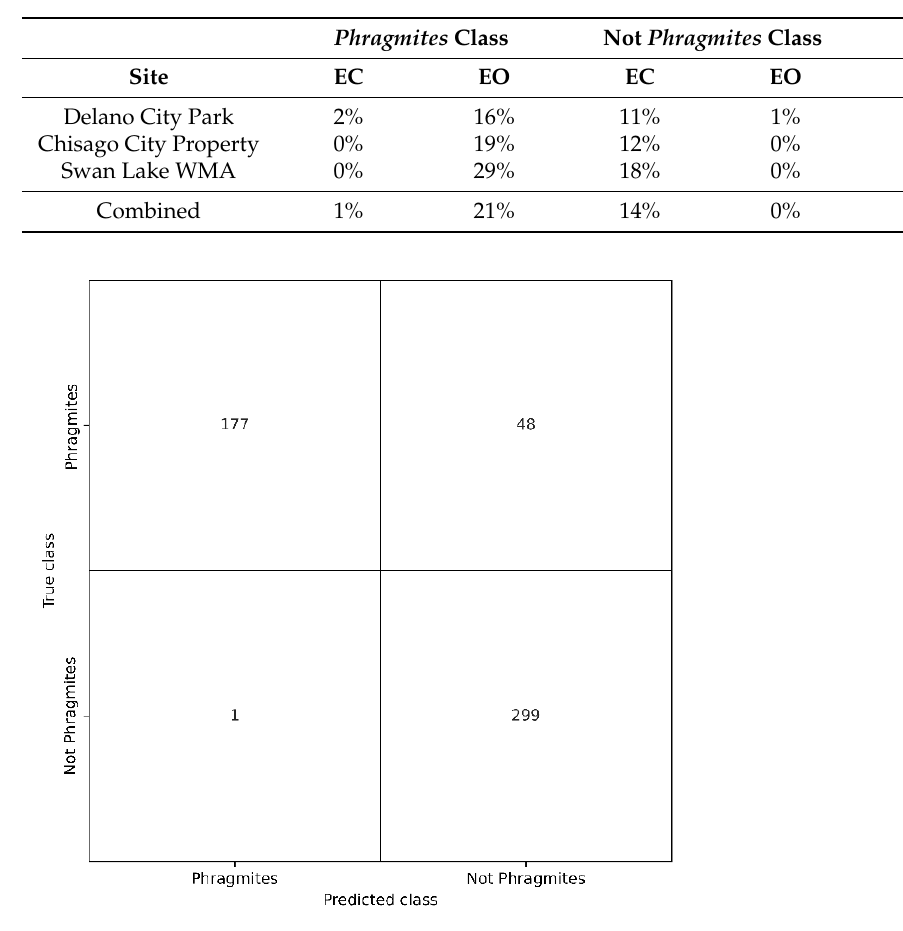
Figure 9. Combined confusion matrix for the three validation sites classified using an artificial neural network with the post-ML OBIA rule set. A classification accuracy of 91% was achieved.